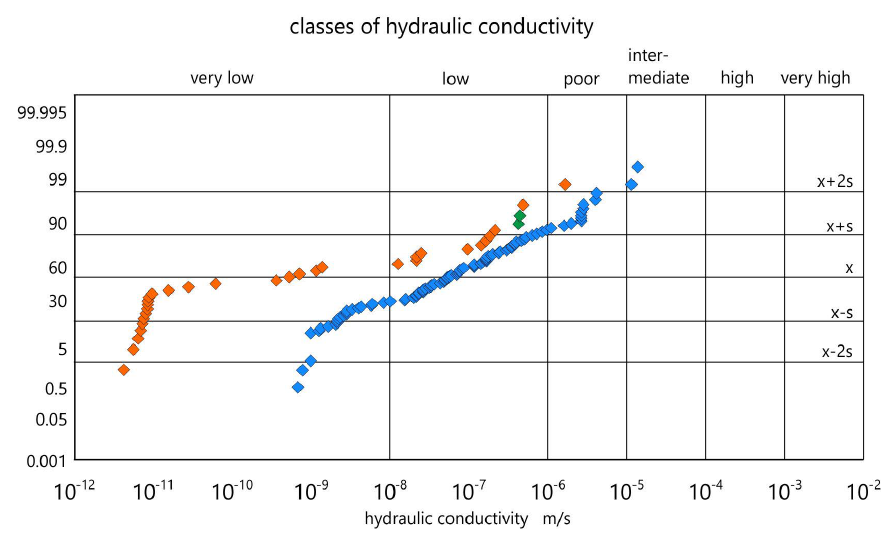
Figure 18. Values of the hydraulic conductivity of the middle and lower Bunter sandstone horizons determined from a single well pumping test (blue) ([53]), W-1 well-pumping test (green), and laboratory tests (orange) within the current study. x ± s: mean ± standard deviation, x ± 2s: mean ± 2 times standard deviation. Classification according to the Hydrogeological Dictionary